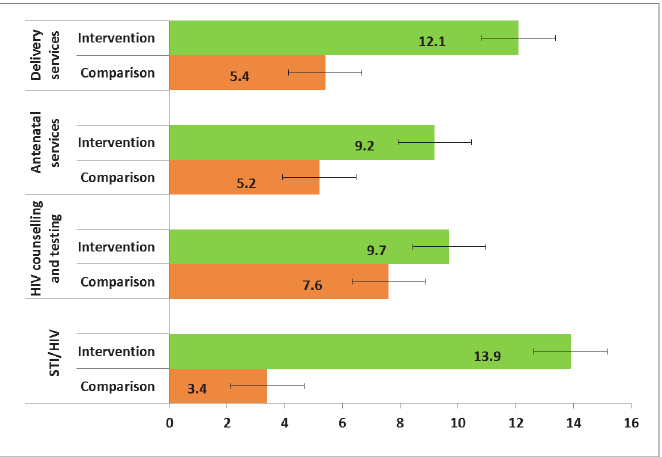
Fig 3. Percentage change in service usage. Percentage differences between baseline and endline in intervention and comparison sites.